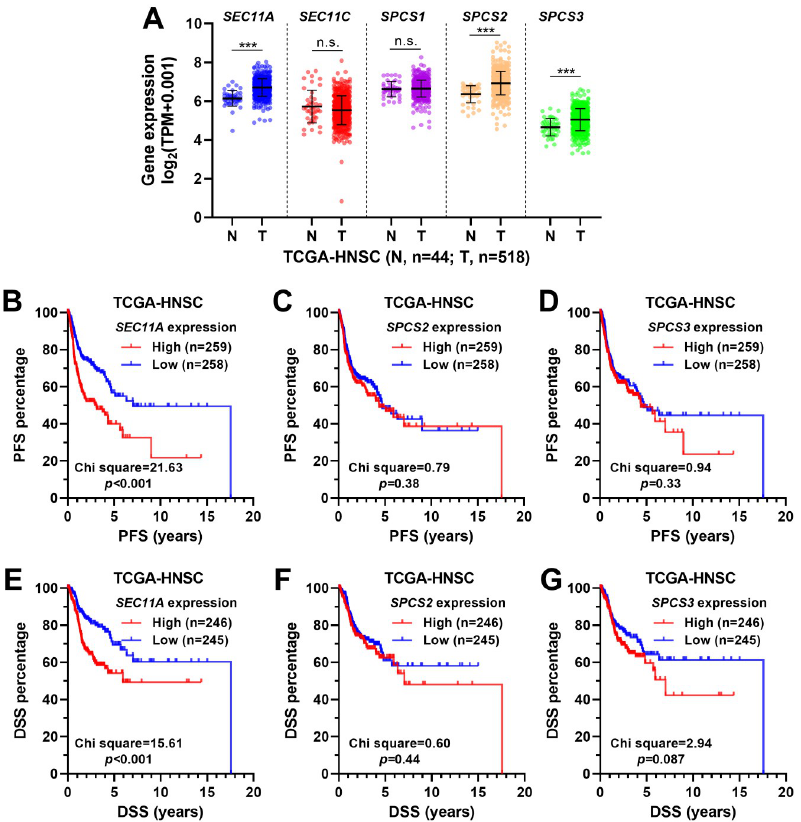
Fig 1. The expression profile of SPC subunit genes and their association with survival. A. The expression of the five SPC subunit genes between primary head and neck squamous cell carcinoma tissues (n = 518) and tumor-adjacent normal tissues (n = 44), TCGA-HNSC. B-G. K-M survival analysis was performed to compare the differences in PFS (B-D) and DSS (E-G). Patients were grouped by median expression of SEC11A (B and E), SPCS2 (C and F) and SPCS3 (D and G) expression. Log-rank test was used to compare the curves and calculate the p values.